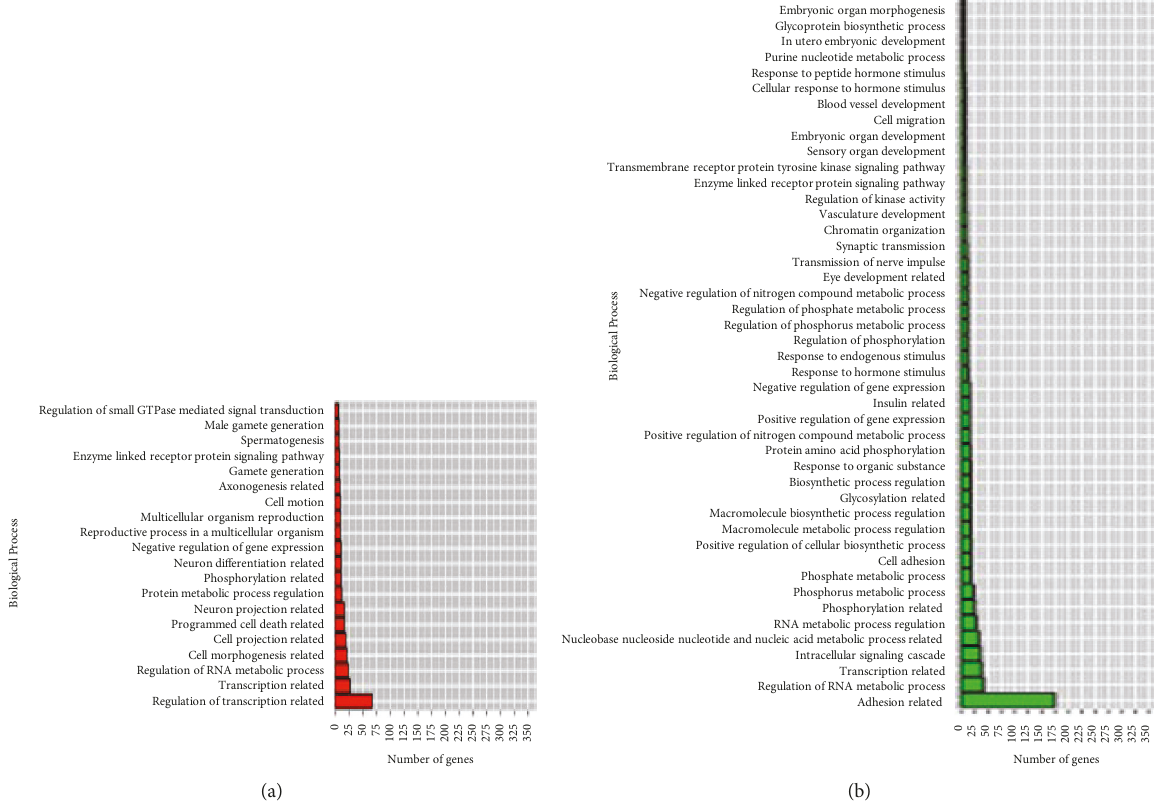
Figure 6: GO terms found for gene targets of di ff erentially expressed miRNAs in response to B. pseudomallei exposure in hPBMCs. (a) Upregulated miRNAs; (b) downregulated